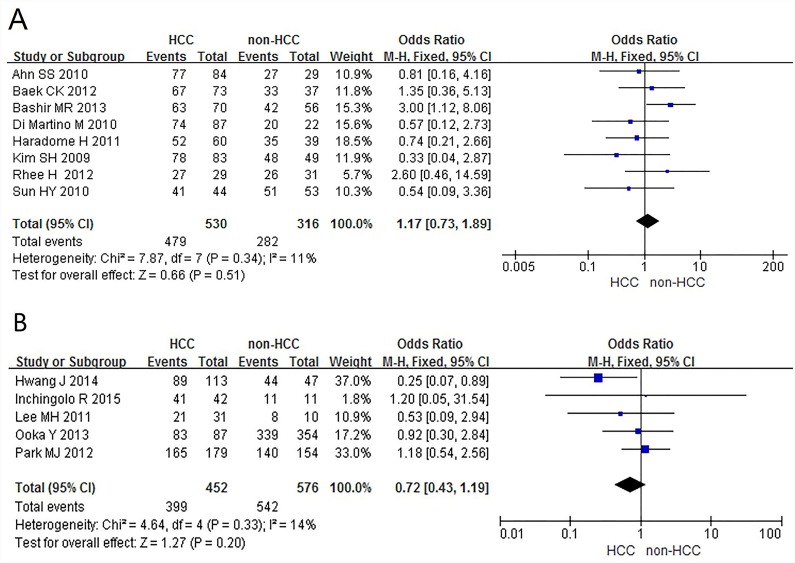
Heterogeneity test results.(A) the estimates for Gd-EOB-DTPA-enhanced MRI in HCC diagnosis. (B) the estimates for combination of Gd-EOB-DTPA-enhanced MRI and DWI sequence in HCC diagnosis.